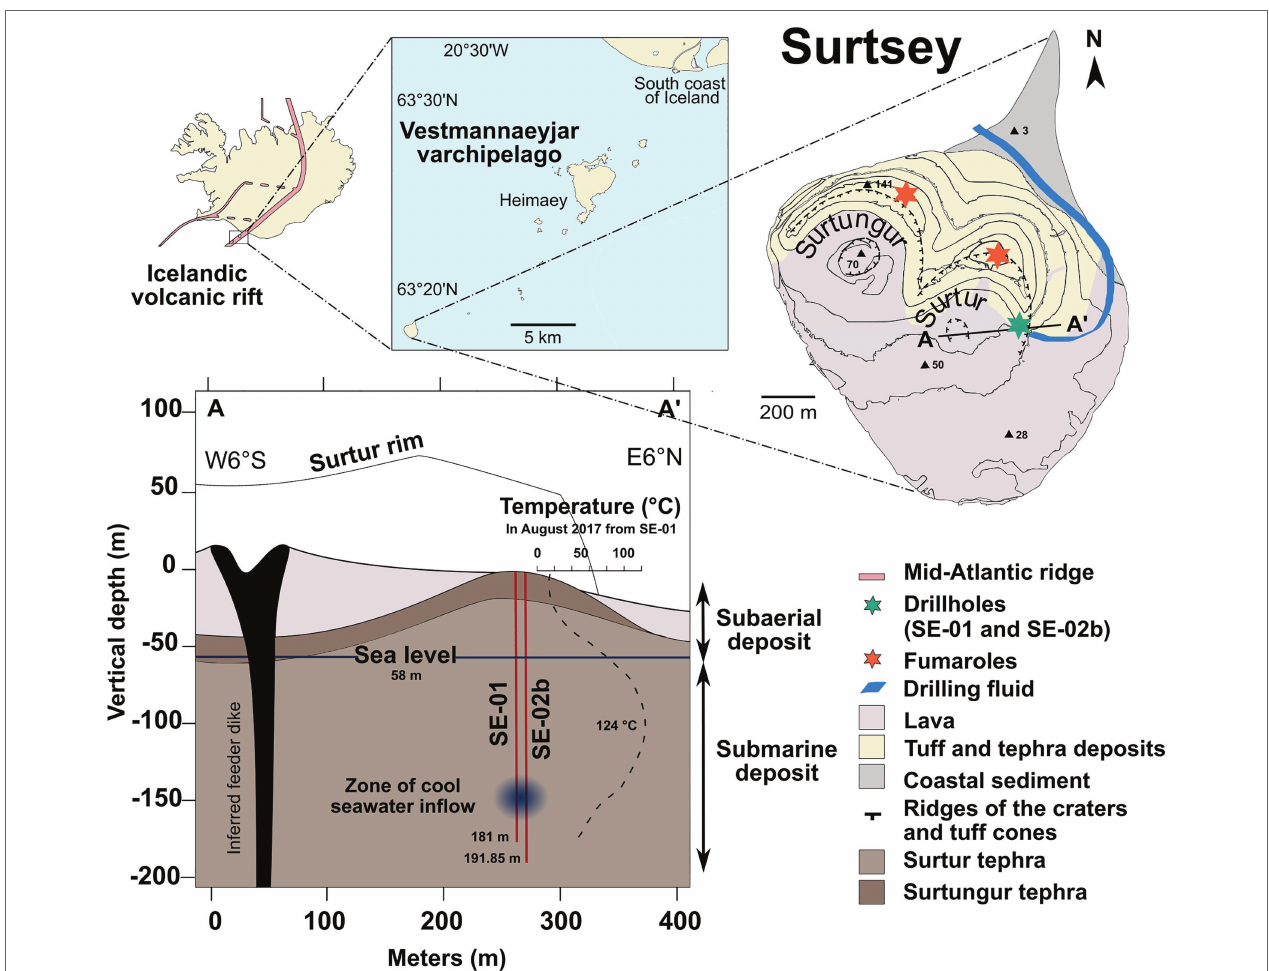
FIGURE 1 | Location of the study area of the south coast of Iceland. Map of the Surtsey volcanic island within the Westman Islands (Vestmannaeyjar) archipelago and location of sampling sites: 1979 borehole SE-01 and 2017 borehole SE-02b (green star), drilling fluid (blue line), and fumaroles (orange stars). Schematic cross section of Surtur crater showing the geological setting of the subsurface deposits and the location of the time-lapse cored boreholes (see Jackson et al., 2019b) and a zone of seawater